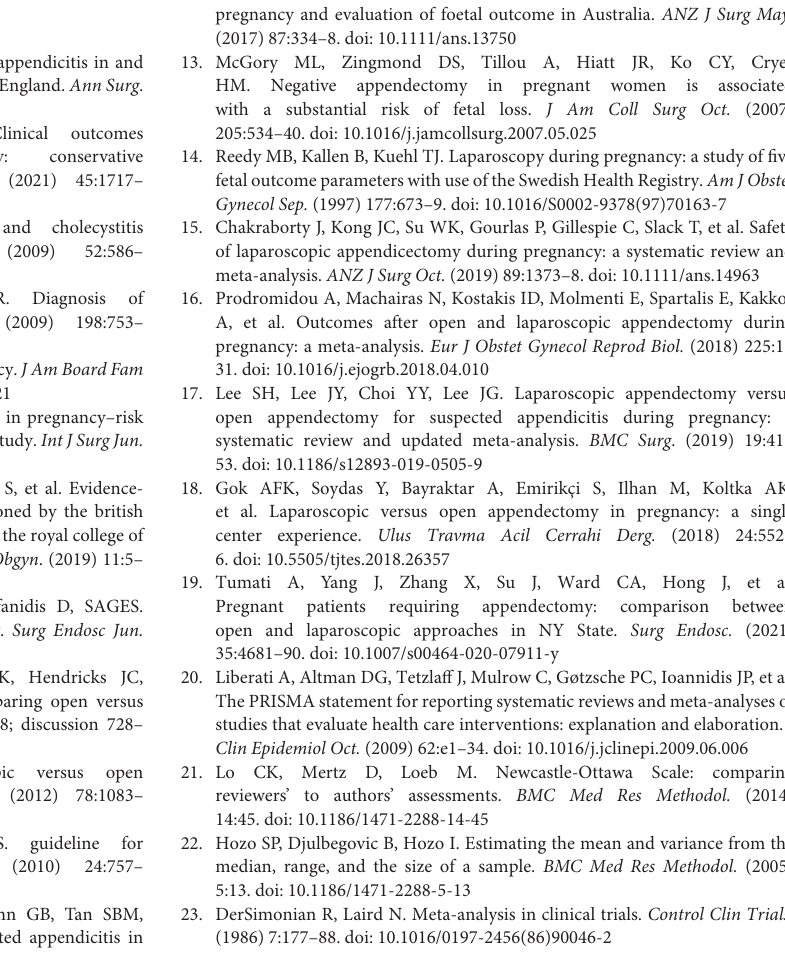
Supplementary Figure 1 | Forest plot for the distribution of complicated appendicitis between LA and OA groups. Supplementary Figure 2 | Forest plot for the gestational age at the surgery between LA and OA groups. Supplementary Table 1 | Pneumoperitoneum status of included